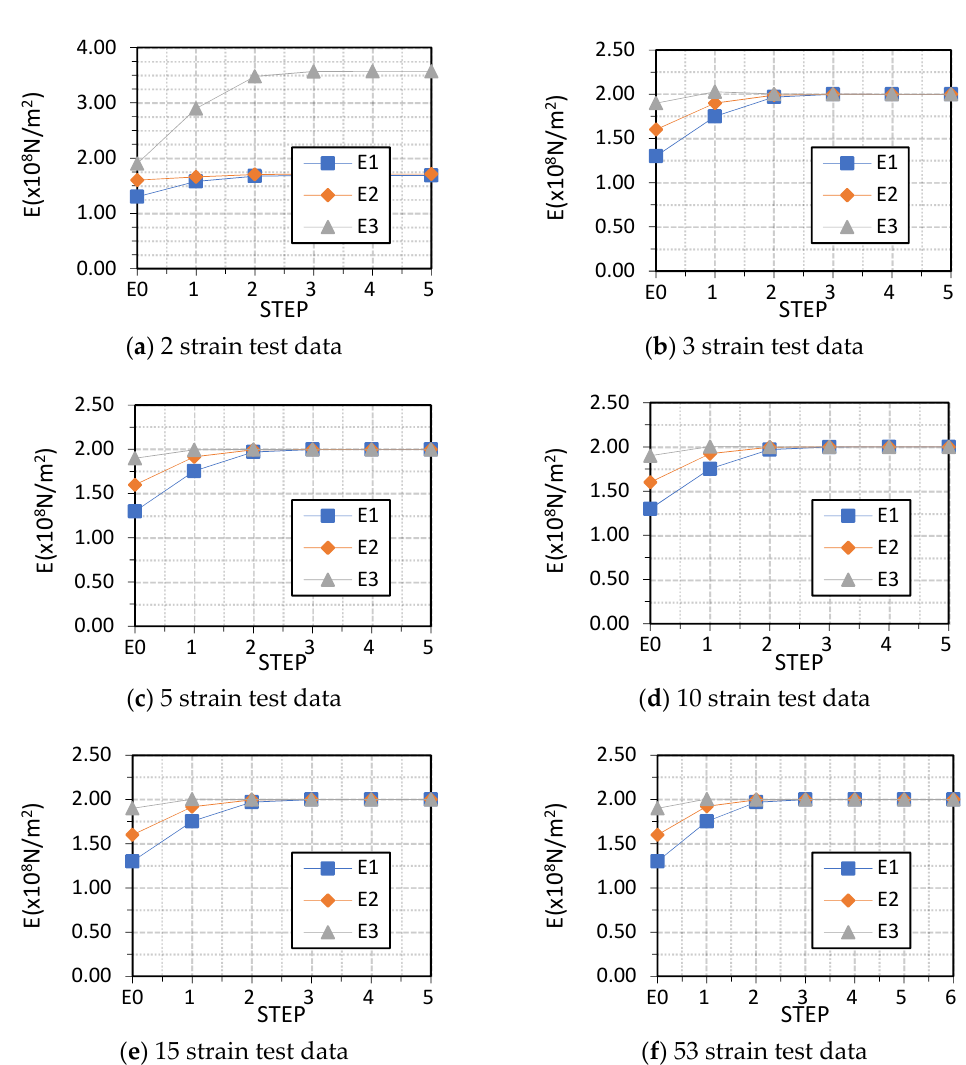
Figure 3. Calculation results of different numbers of strain test data.